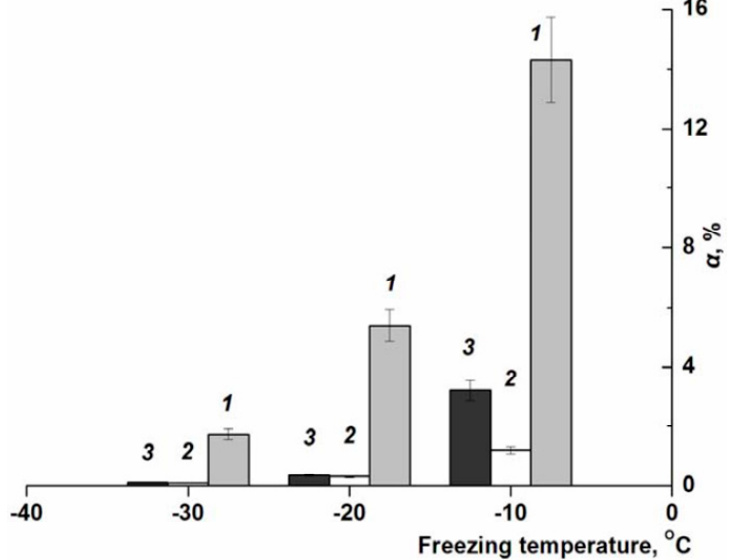
Figure 4. Relative content ( α ) of mobile (nonfrozen) water in the macroscopically frozen aqueous Na-ALG solutions of different concentrations of the polymer: 20 ( 1 ), 30 ( 2 ), and 35 ( 3 ) g/L, when the samples have been frozen at various minus temperatures.